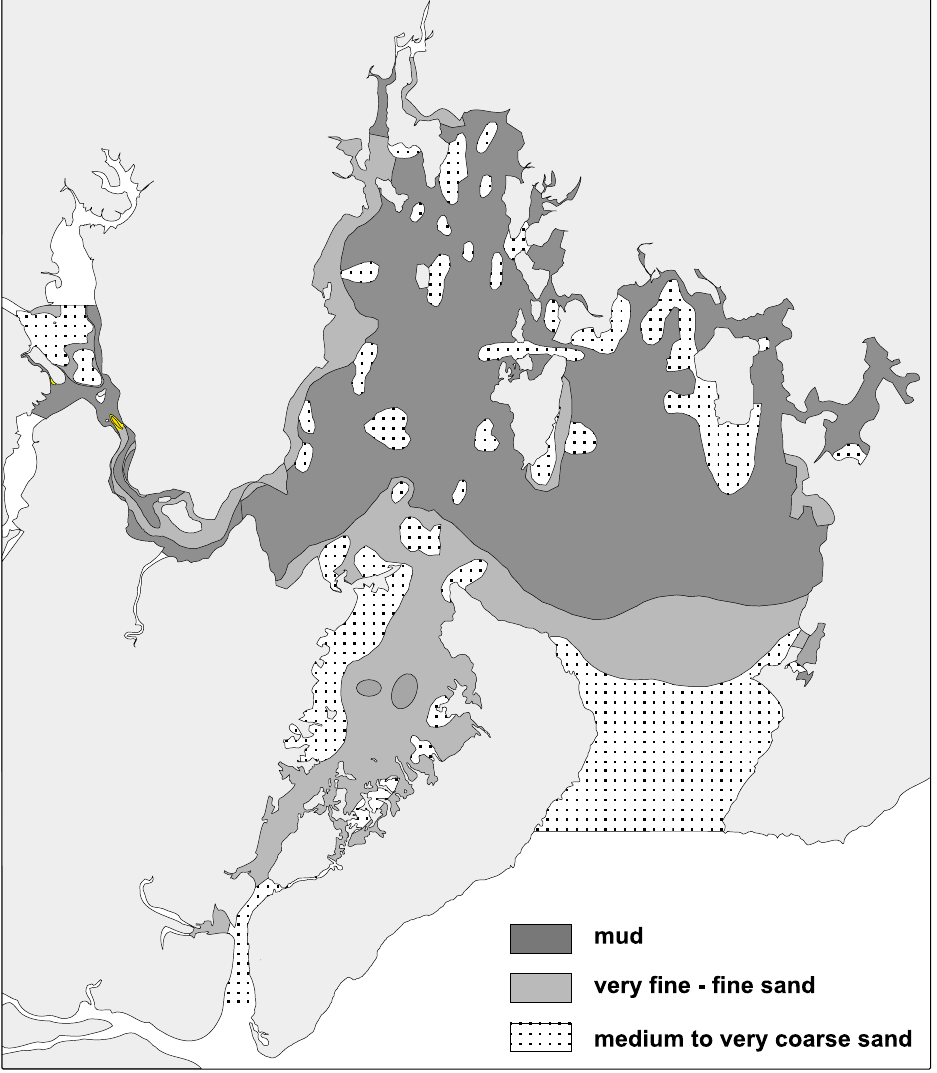
Fig. 5 – Surface sediment size distribution inside the TSB. Data compiled from Bittencourt et al. (1976) (D 50 ) for the main part of TSB, Brichta (1977) (D 50 ) for Paraguaçu Channel and from Avanzo (1977) (M d ) for Iguape